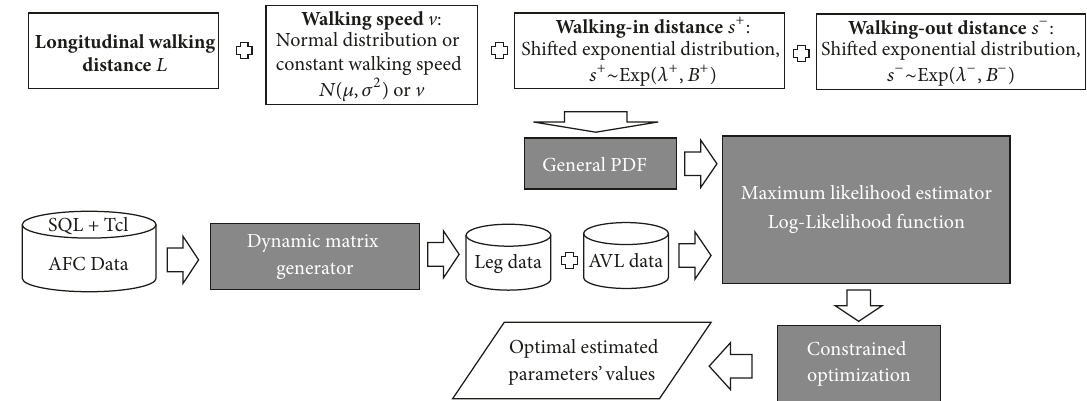
Figure 3: Modeling and optimization schema based on